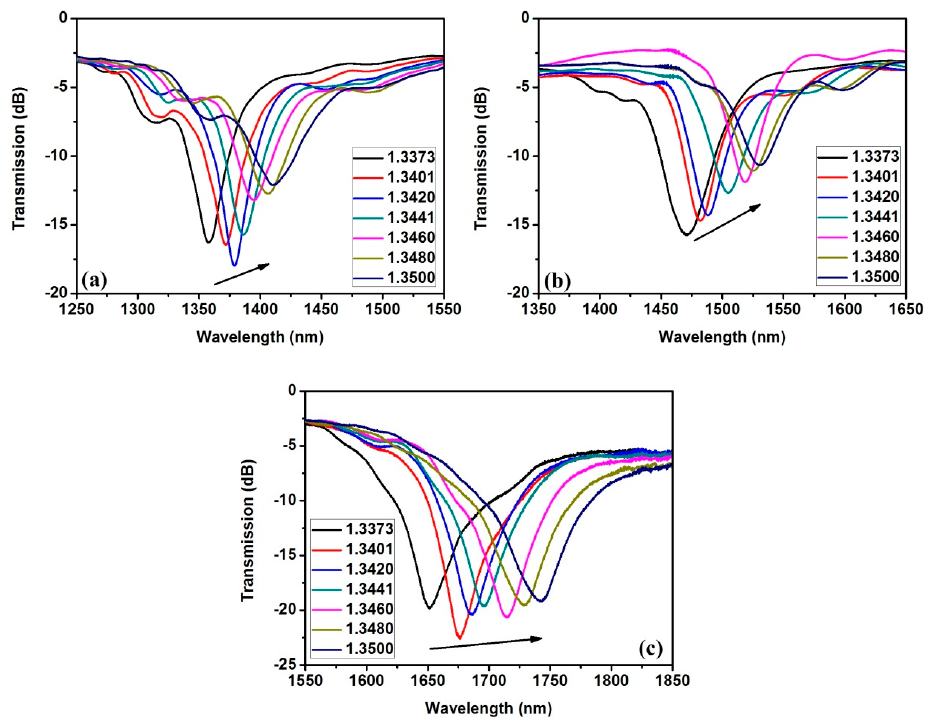
Figure 7. Transmission spectra shift with increasing SRI for different TiO 2 film thickness values. ( a ) 39.7 nm; ( b ) 45.2 nm; ( c ) 50.9 nm.